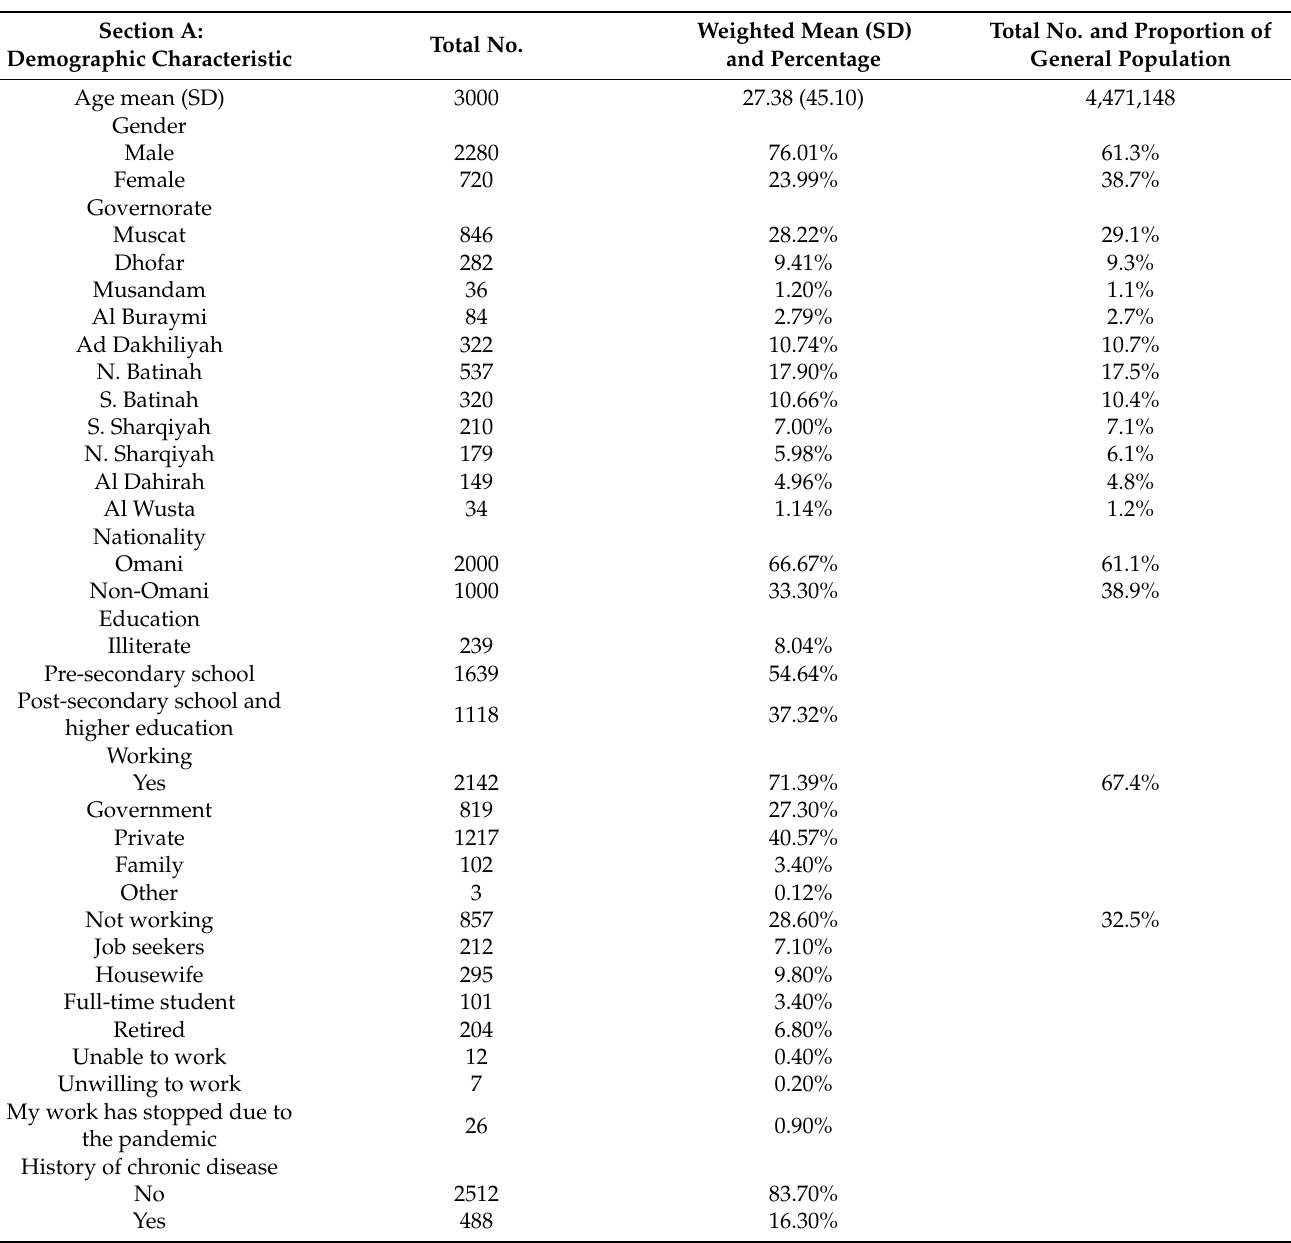
Table 1. Sociodemographic information of the total number of participants